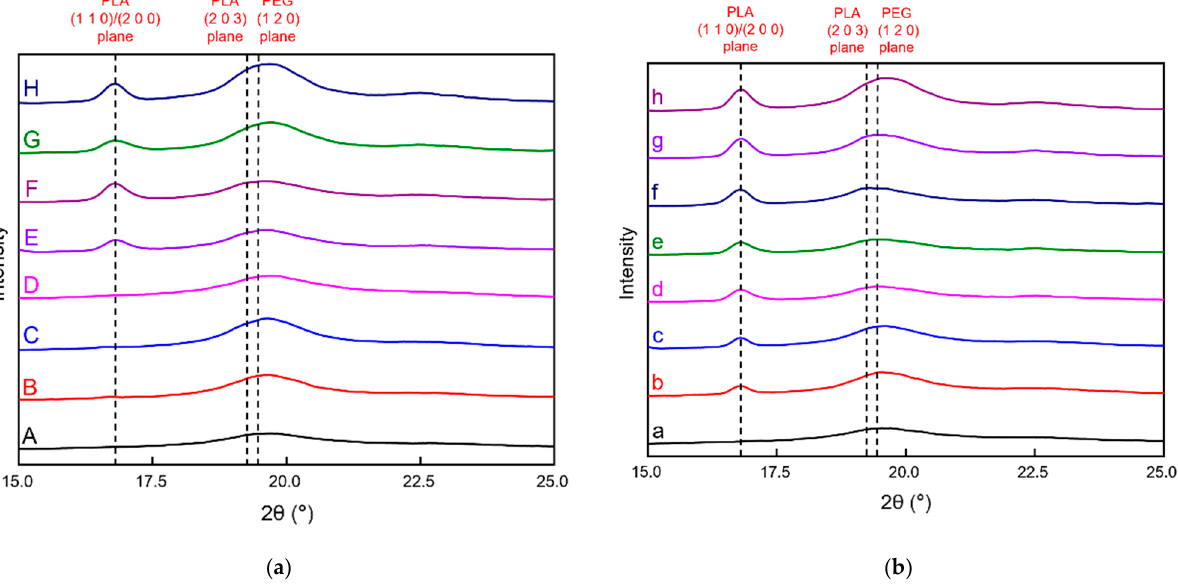
Figure 12. XRD patterns of untreated and heat-treated ( a ) PEG–PLA(70) and PEG–PLA(70) + neat PLA, and ( b ) PEG– PLA(140) and PEG–PLA(140) + neat PLA specimens. The temperatures, durations, and notations corresponding to this heat treatment are listed in Table 2.